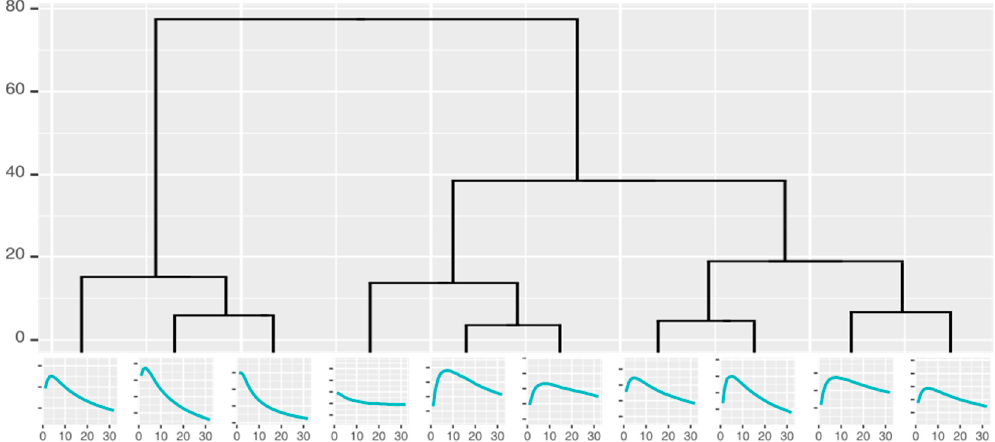
Figure 4. Cluster taxonomy of the responses from one gold nanoparticle